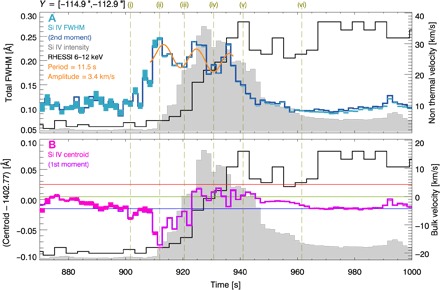
Temporal evolution of the Si IV line properties during the flare.(A) The total FWHMs and nonthermal velocities vnth (turquoise) and (B) the centroid positions and bulk velocities v (purple), observed over a 2″ region along the north-south direction. Both the results of the Gaussian fitting and the moment analysis (see legend) give near-identical results. The Si IV integrated intensity (gray) and the RHESSI 6- to 12-keV light curve (black) are displayed. The dashed lines indicate the times of six spectral lines shown in Fig. 2. Top: A sinusoidal function is fitted to the variations in vnth, estimating the period P and amplitude A (see legend). Bottom: Inferred reference wavelength (lime) and uncertainty (red and blue).